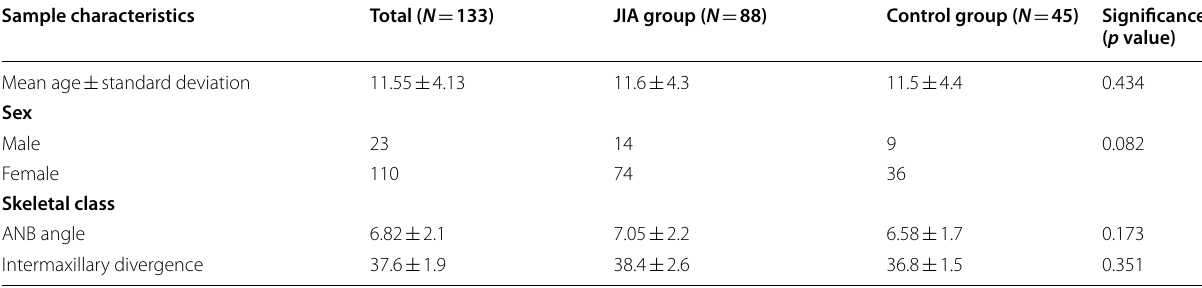
* p value < 0.05 was considered as statistically significant